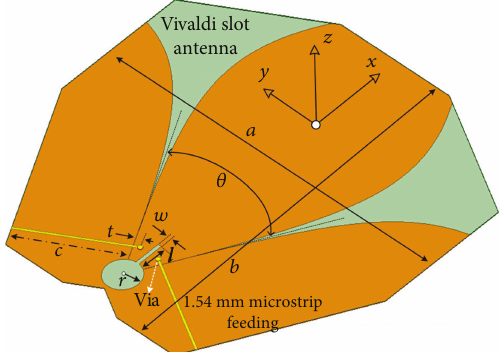
Figure 2: A Vivaldi antenna designed to eliminate the cellular narrow band problem